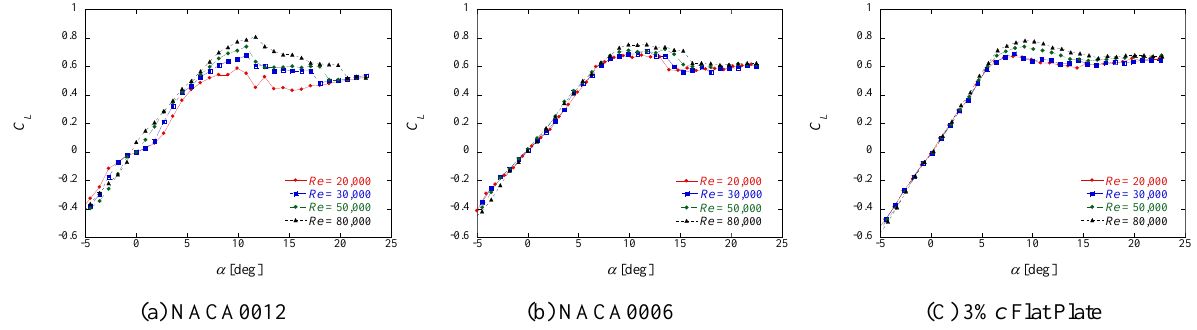
Fig. 4 Lift curves for each airfoil with zero flap deflection in Reynolds number from Re = 20,000 to Re = 80,000. The lift curves of NACA0012 are highly nonlinear in particular at Re = 20,000, whereas those of NACA0006 and 3% c flat plate show high